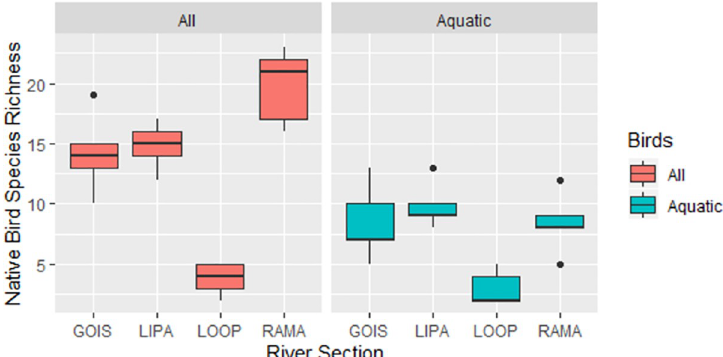
Fig 2. Boxplots comparing native bird species richness of all birds (left) and “aquatic” birds (right) among the four sections of the river described in the methods. The five study points of each river section are combined (n = 5 for each section). When species richness of all native birds is compared, differences between GOIS and LIPA are not statistically significant, but all other differences are significant (Wilcoxon test, p < 0.05). When only aquatic bird species richness is compared, only LOOP differs significantly from the other